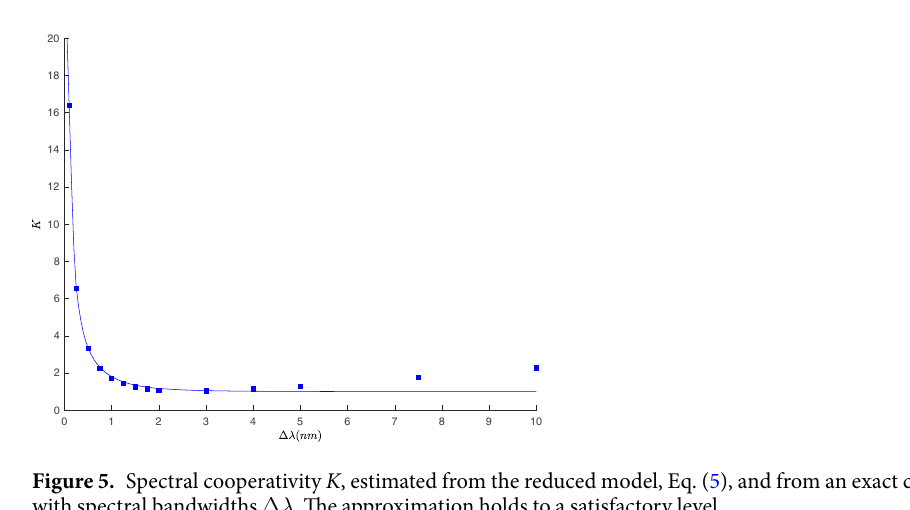
Figure 5. Spectral cooperativity K , estimated from the reduced model, Eq. (5), and from an exact calculation with spectral bandwidths Δ λ . The approximation holds to a satisfactory